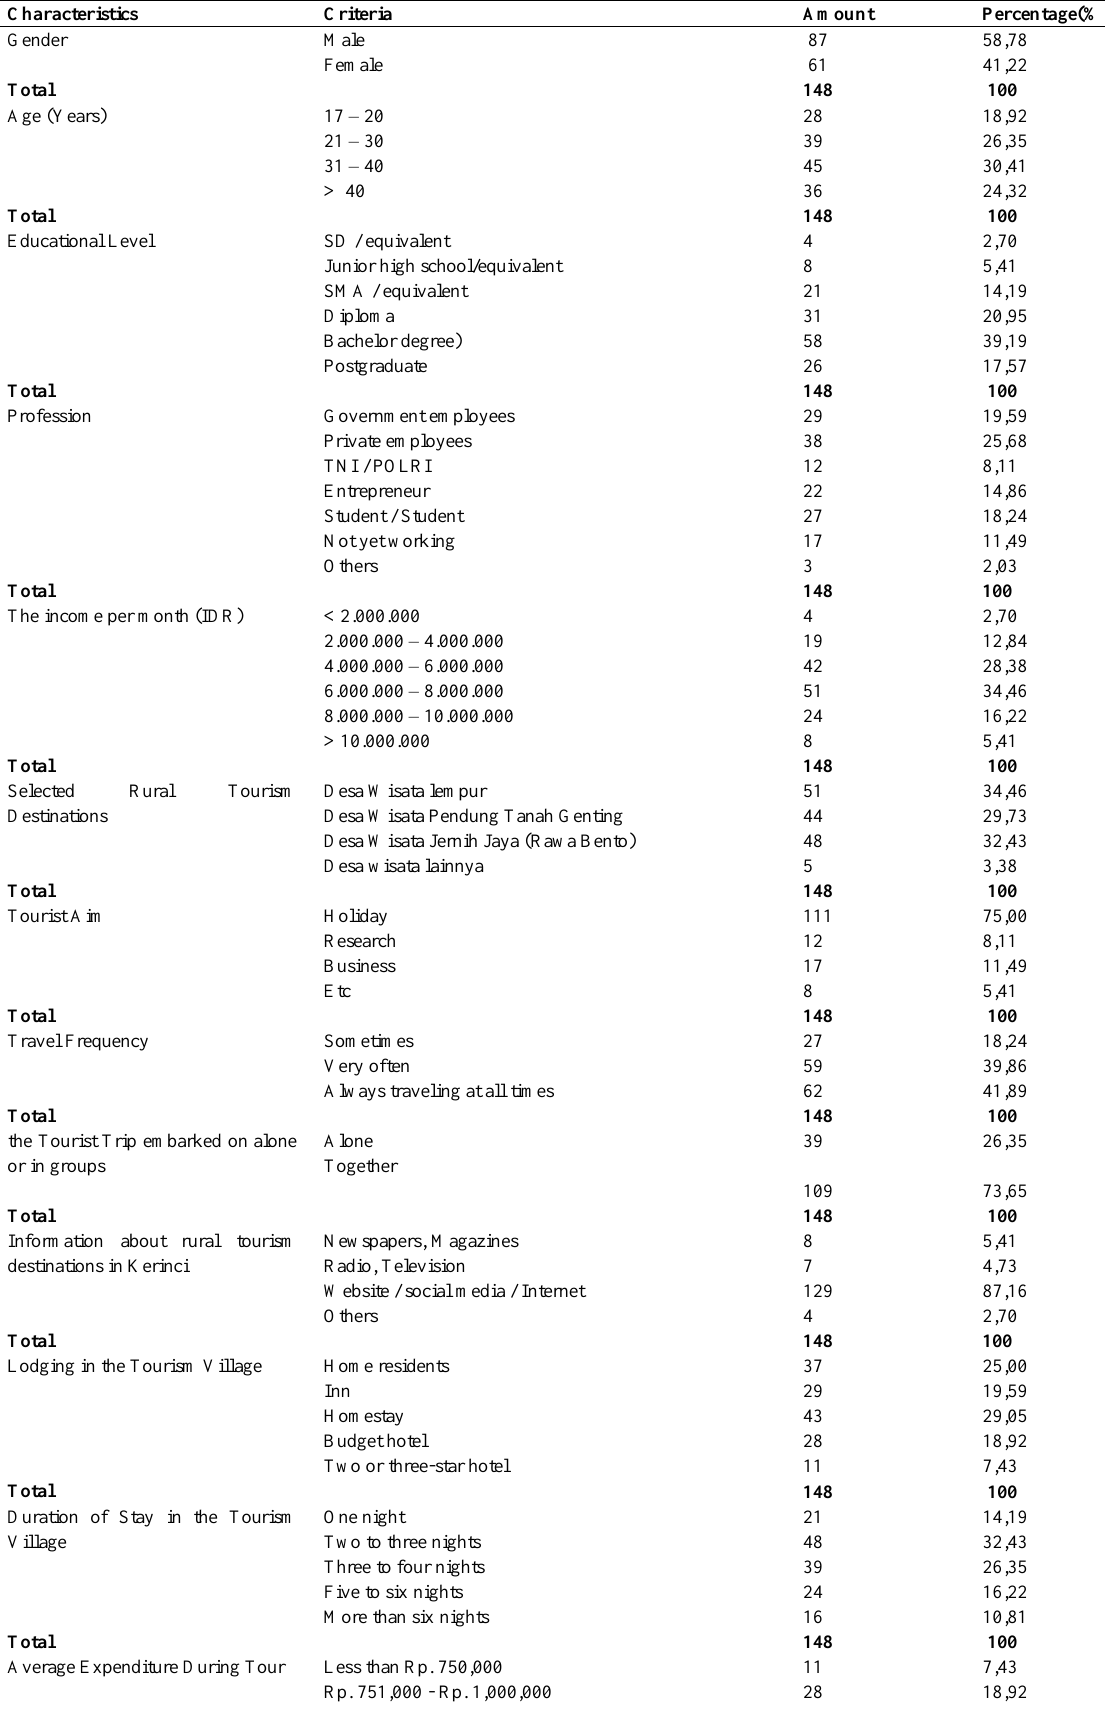
Table 1: Characteristics of